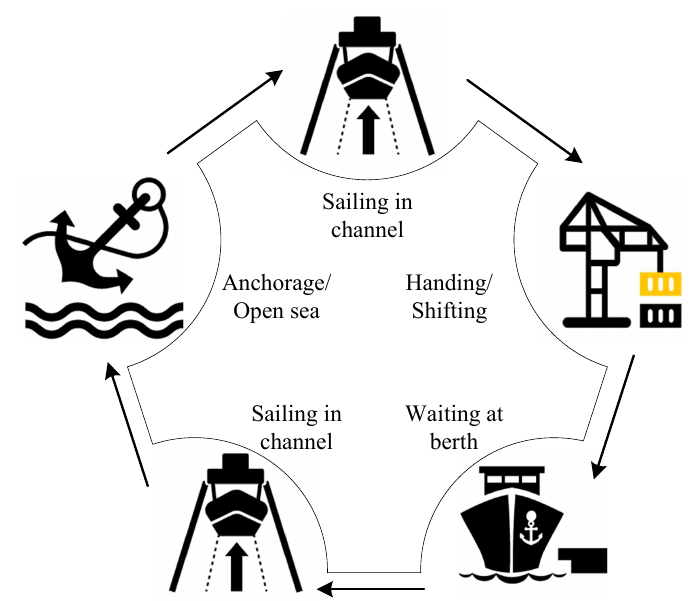
Figure 1. Simplified sketches of ship entry and exit operation